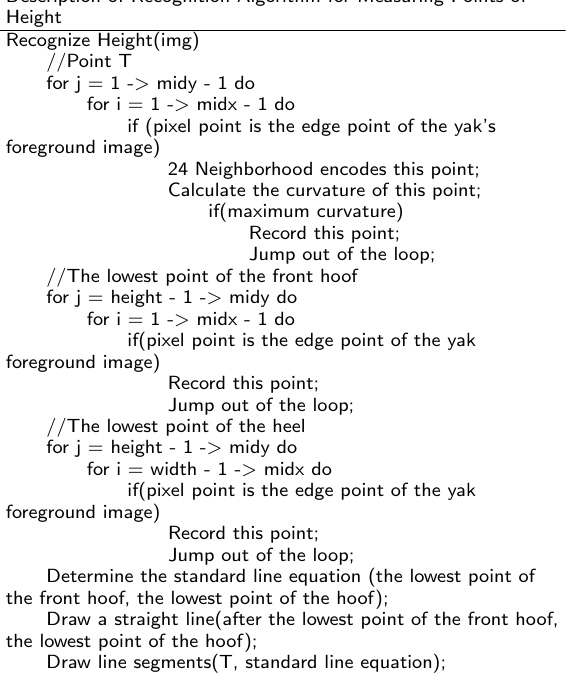
Algorithm 2 Recognition Algorithm for Measuring Points of Description of Recognition Algorithm for Measuring Points of